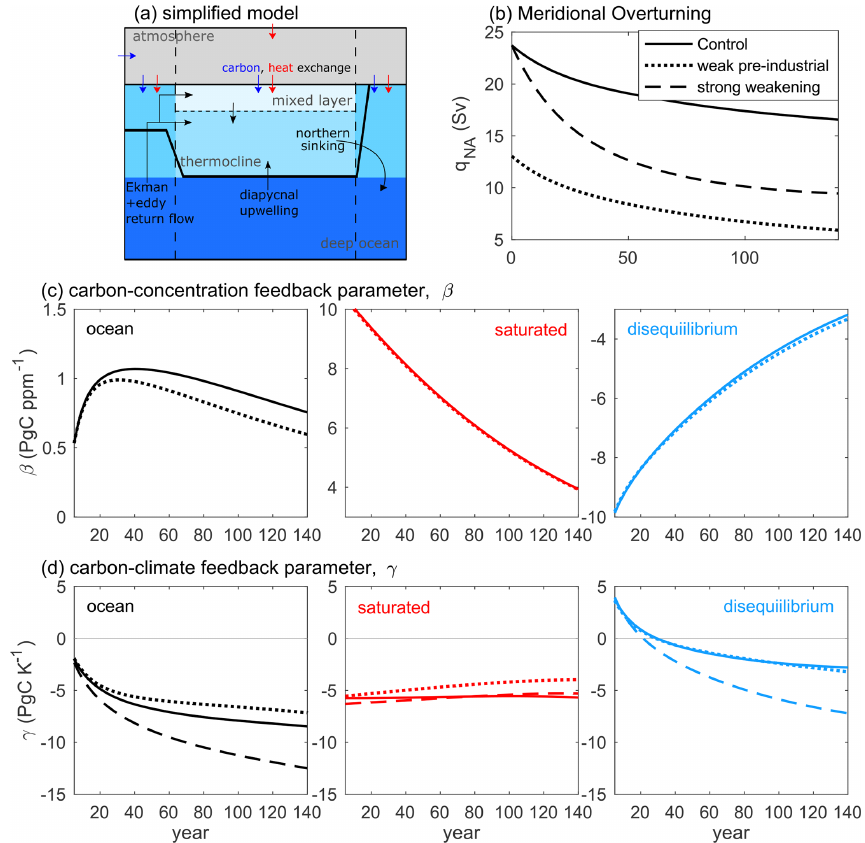
Figure 7. (a) A simplified climate model with overturning circulation, including a slab atmosphere, an upper layer of light water consisting of a thermocline layer and a surface mixed layer in the low and middle latitudes, two upper layers at southern and northern high latitudes, and a lower layer of dense water. (b) Meridional overturning in the three experiments forced by a 1%yr − 1 increase in atmospheric CO 2 : (i) control experiment (solid line), (ii) weaker pre-industrial overturning (dotted line) and (iii) larger reduction in the overturning with climate change (dashed line). (c) The ocean carbon–concentration feedback parameter, β , and (d) the ocean carbon–climate feedback parameter, γ , along with their saturated and disequilibrium parts, in the experiments with different meridional overturning. The estimates of β and γ are based on the fully coupled simulations (COU) and the biogeochemically coupled simulations (BGC). Note that for the “global” ocean of the simplified model, β and γ are equivalent to β ∗ and γ ∗